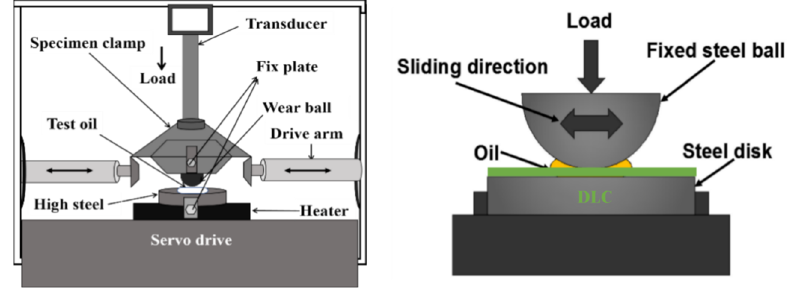
Figure 2. Schematic diagram of SRV-IV tribo-tester and steel/DLC friction pair.